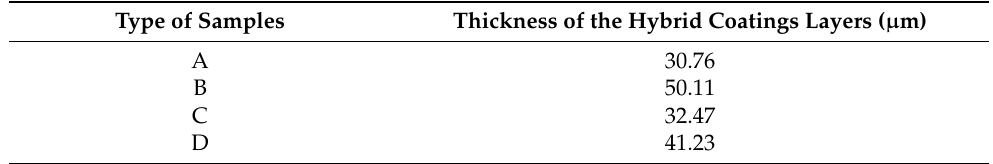
Table 2. The thickness of epoxy resin/zinc hybrid coatings.